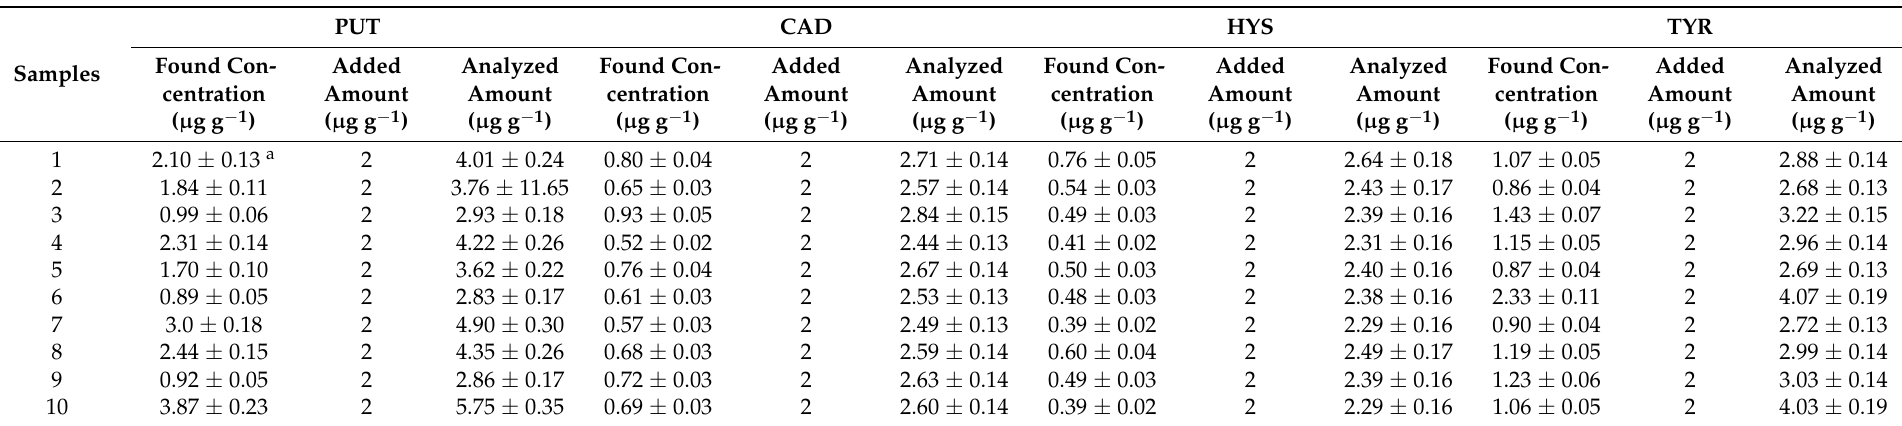
Table 3. Analytical results of BAs in non-alcoholic beer samples using the offered